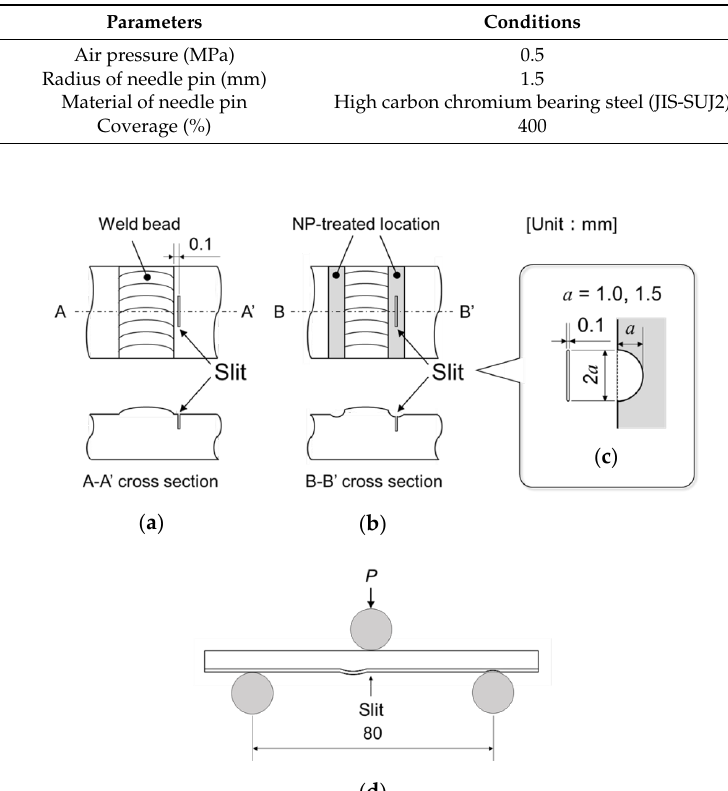
Figure 4. Overview of the slit and loading point: ( a ) position of the slit with respect to the weld bead; ( b ) position of the slit with respect to the weld bead and the location of the NP treatment; ( c ) shape and dimensions of the semi-circular slit where a is the slit depth; and ( d ) relationship between the slit position and loading